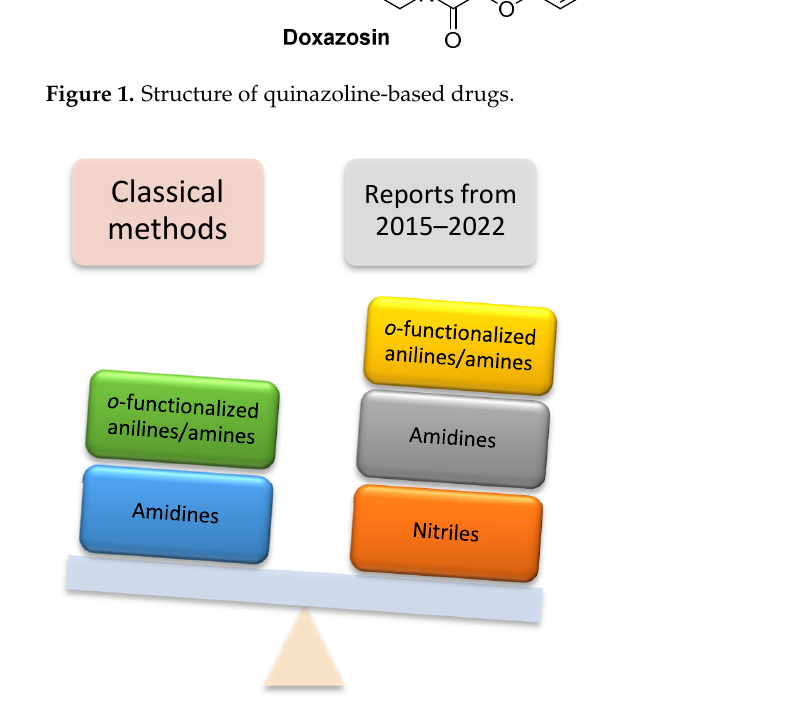
Figure 2. Substrates scope in classical methods vs. reports between 2015–2022.